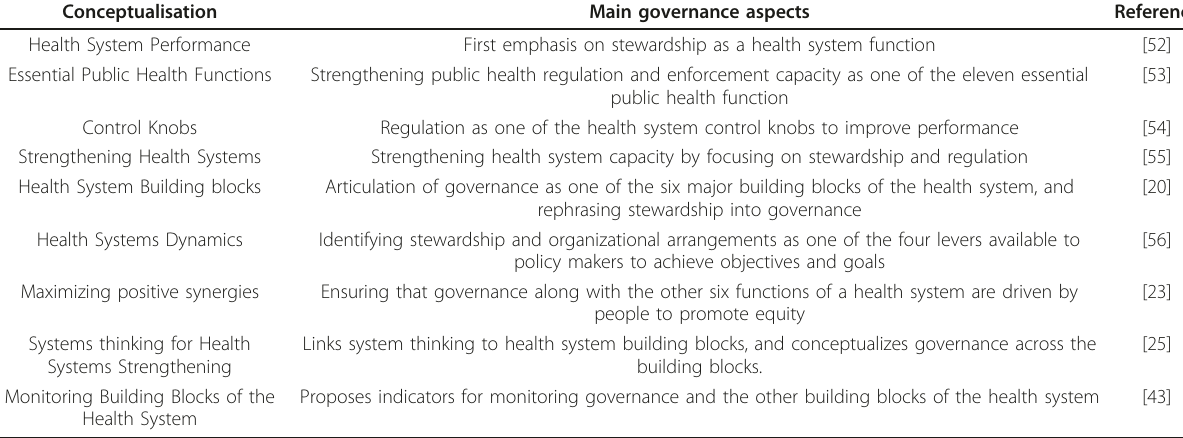
Table 1 Chronology of major health system definitions, frameworks and concepts